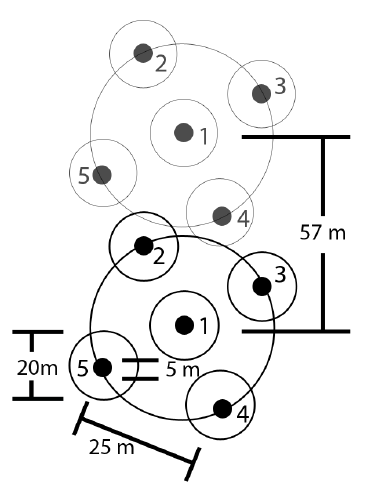
Figure 2. LOLA spot pattern (Smith et al. 2010). Altimetry obtained from the Lunar Orbiter Laser Altimeter (LOLA) is used to increase the absolute accuracy of NAC DEMs. LOLA was designed to measure the shape of the Moon by precisely measuring the range from the spacecraft to the surface, and incorporating precision orbit determination of LRO by referencing surface ranges to the Moon’s center of mass. Its primary objective is to produce a global geodetic grid for the Moon to which all other observations can be precisely referenced (Smith et al. 2010). LOLA is a pulse detection time-of-flight altimeter that incorporates a five-spot pattern to measure the precise distance to the surface at 5 spots simultaneously, thus providing 5 profiles for each orbit. LOLA fires at a fixed, 28 Hz rate, so that for a nominal 1600 m/s ground track velocity, there is one shot approximately every 57 meters. At a nominal 50 km altitude, each spot within the five- spot pattern has a diameter of 5 meters while each detector field of view has diameter of 20 meters. The spots are 25 meters apart and form a cross pattern canted by 26 ° counter-clockwise to provide five adjacent profiles (Figure 2) (Smith et al. 2010, Zuber et al. 2010). The LOLA instrument boresight is aligned with the LROC NAC cameras to enable altimetry collection in the overlap region between NAC-L and NAC-R. By using Earth-based laser ranging tracking and crossover analysis the accuracy of the LOLA dataset is improved.